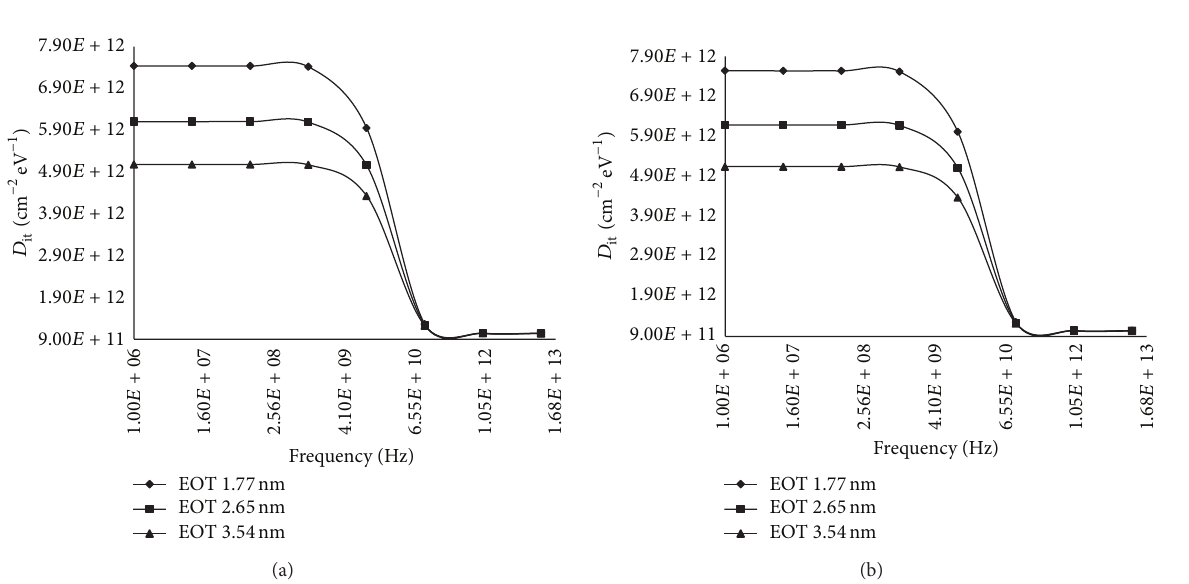
and HfO at different EOT at 2 2